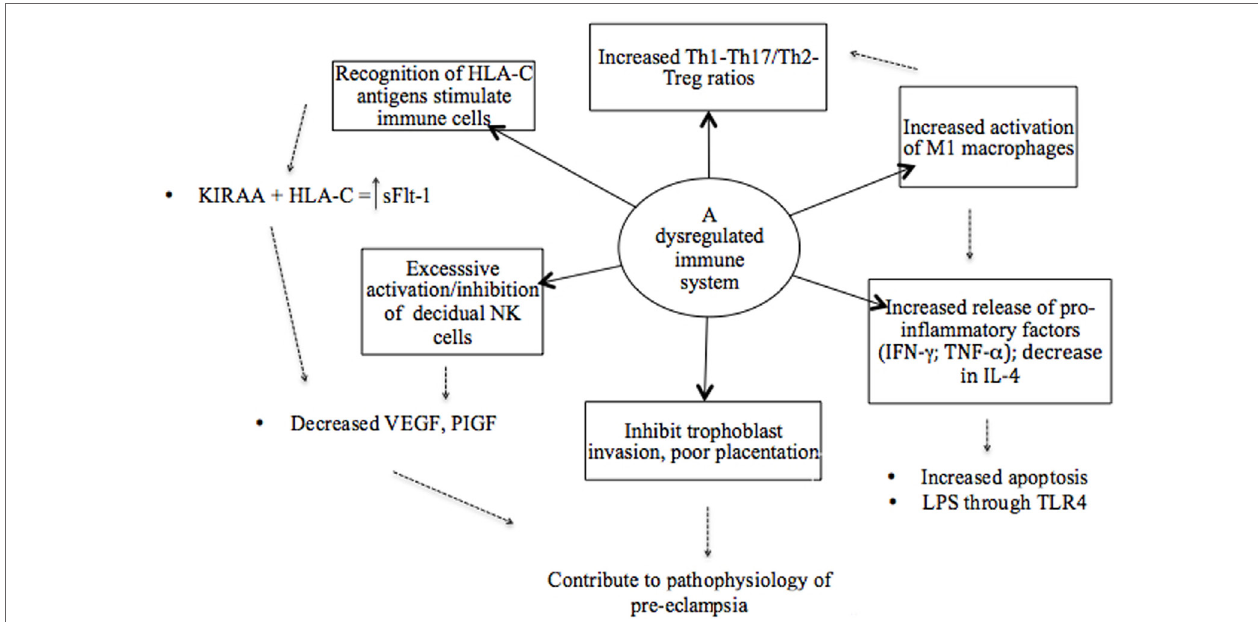
FiGURe 2 | An illustrative model of the various components of a dysregulated immune system in preeclampsia. The recognition of antigens is considered a starting point where immune cells are stimulated based on the interaction between specific killer immunoglobulin-like receptor (KIR) and human leukocyte antigen (HLA) ligand genotypes. Subsequently, a dysregulated immune system in preeclampsia is attributed to an imbalance of pro- and anti-inflammatory cytokines as result of the overactivation of immune cells and pro-inflammatory stimuli that promote inflammation. Therefore, a hyperinflammatory environment in preeclampsia is established by the failure of regulatory